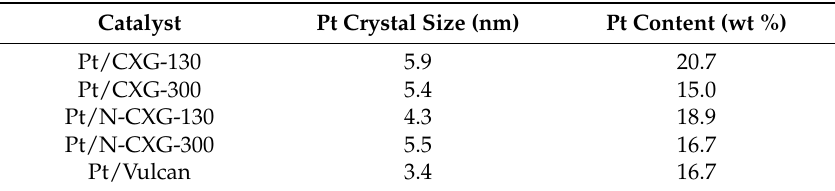
Figure 3. XRD patterns for Pt-catalysts. Table 4. Pt crystal size determined by XRD and percentage of Pt determined by